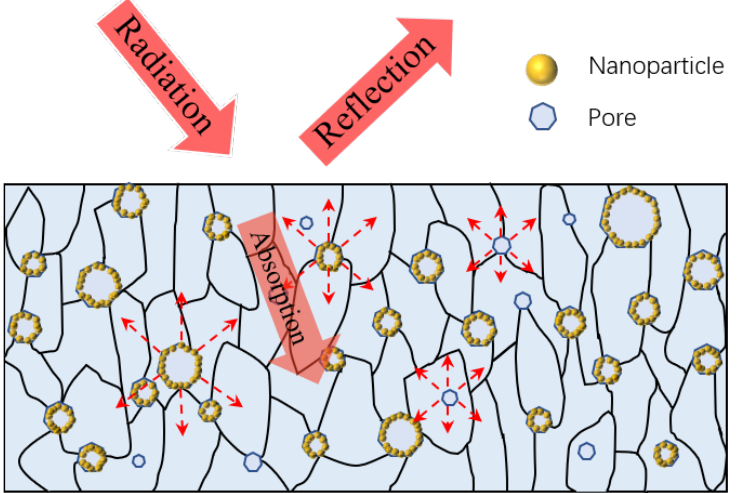
Figure 11. Schematic diagram of radiation in nano-alumina coating.